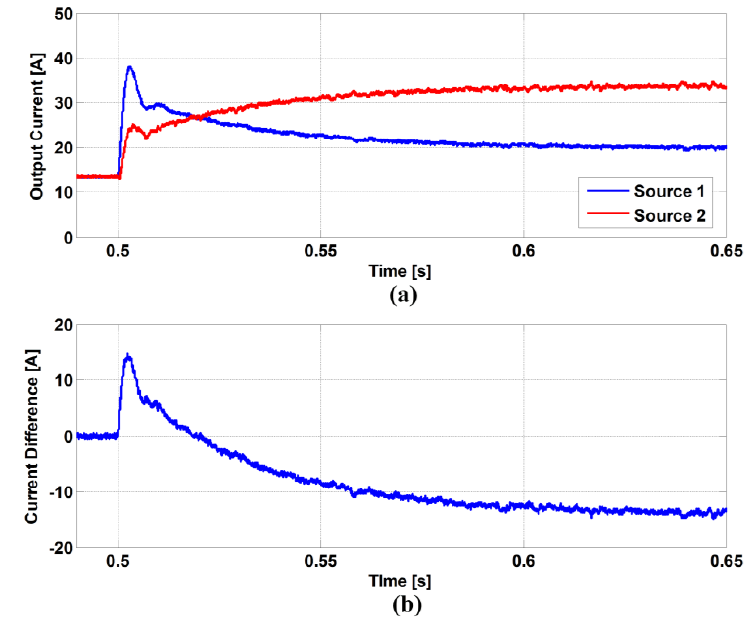
Figure 14. Simulation results with different virtual resistance values. ( a ): Output Current, ( b ): Difference.